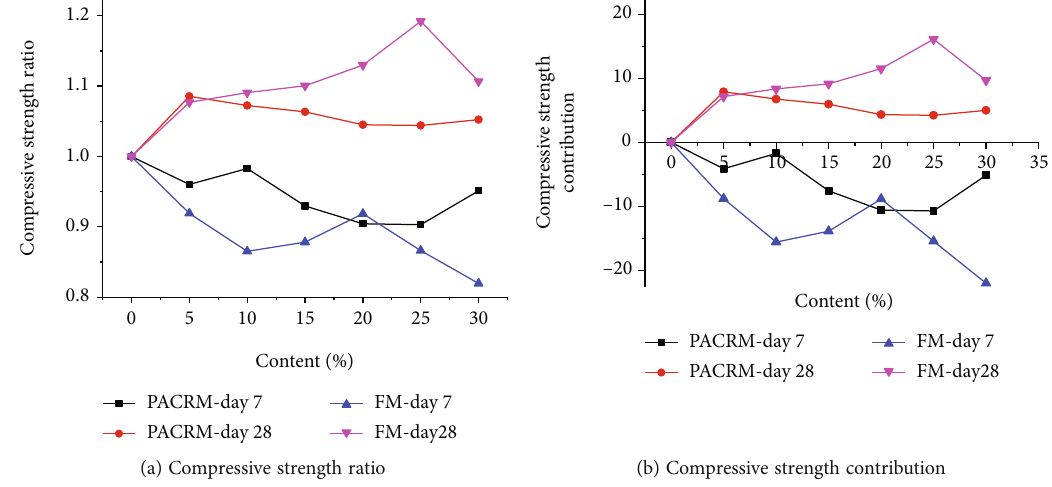
Figure 9: Compressive strength ratio and compressive strength